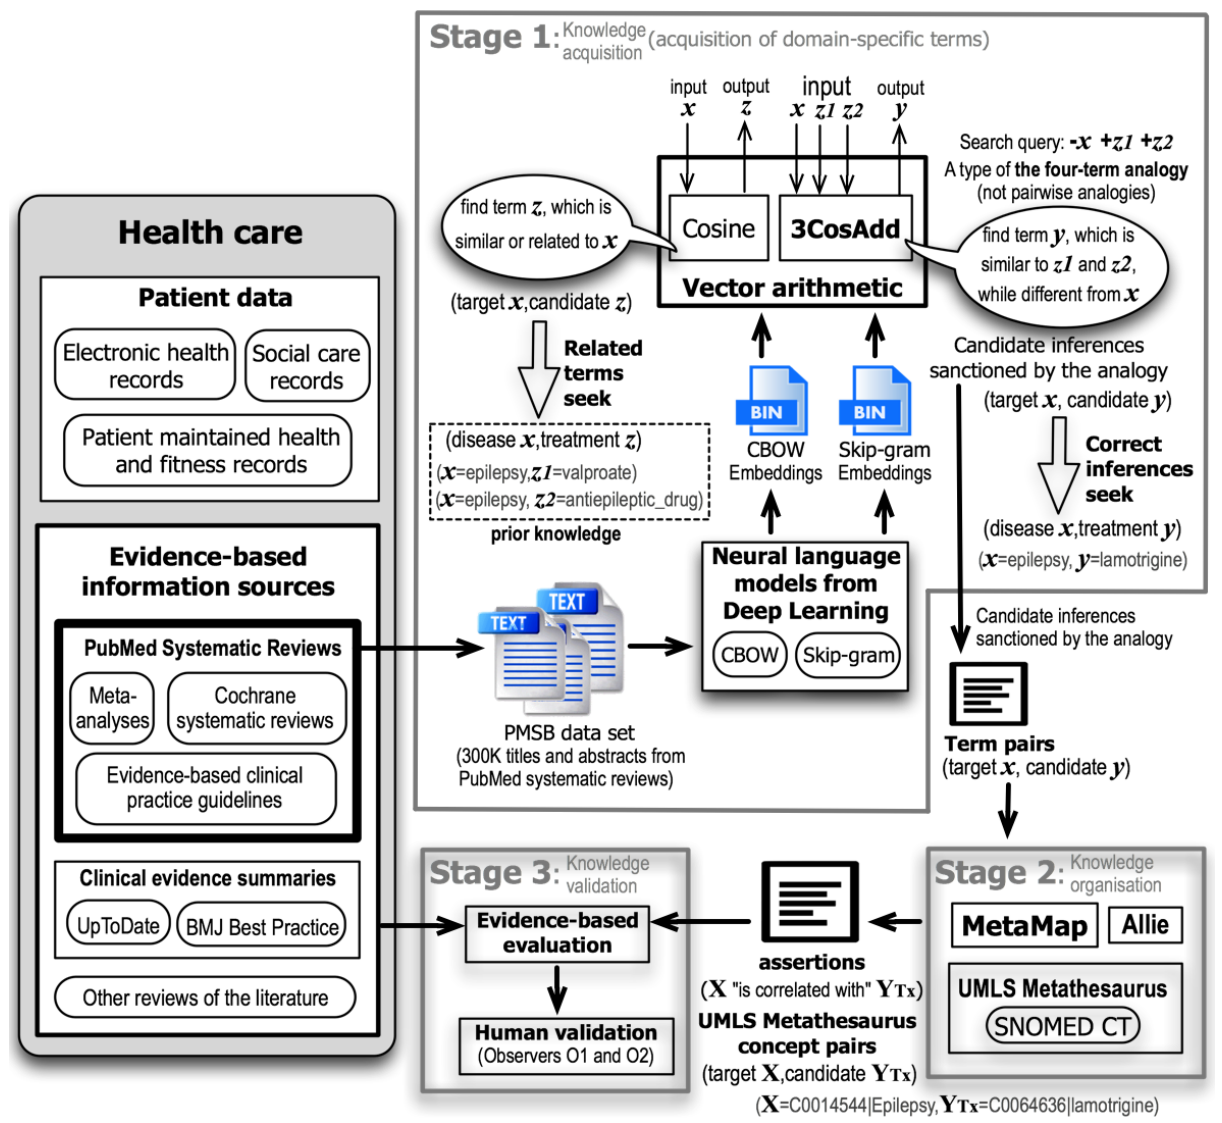
Figure 1. Overview of our SemDeep